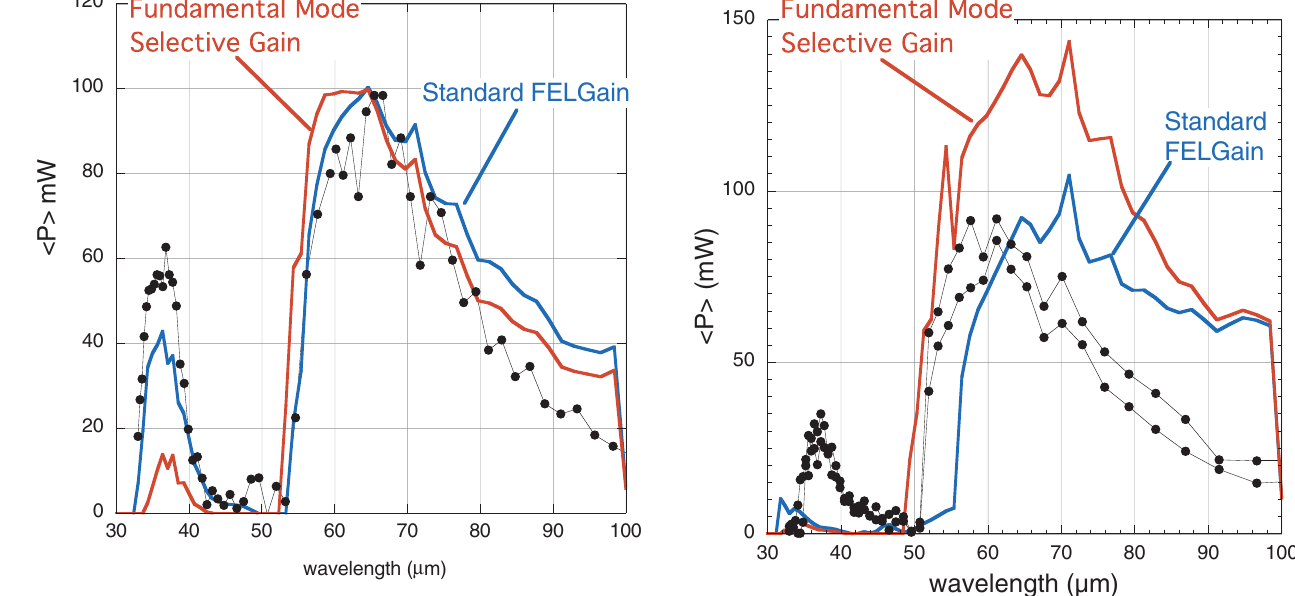
FIG. 4. (Color) Laser power vs centroid wavelength, for toroidal cavity, using hole coupling of 3 mm. Bold lines are simulations.